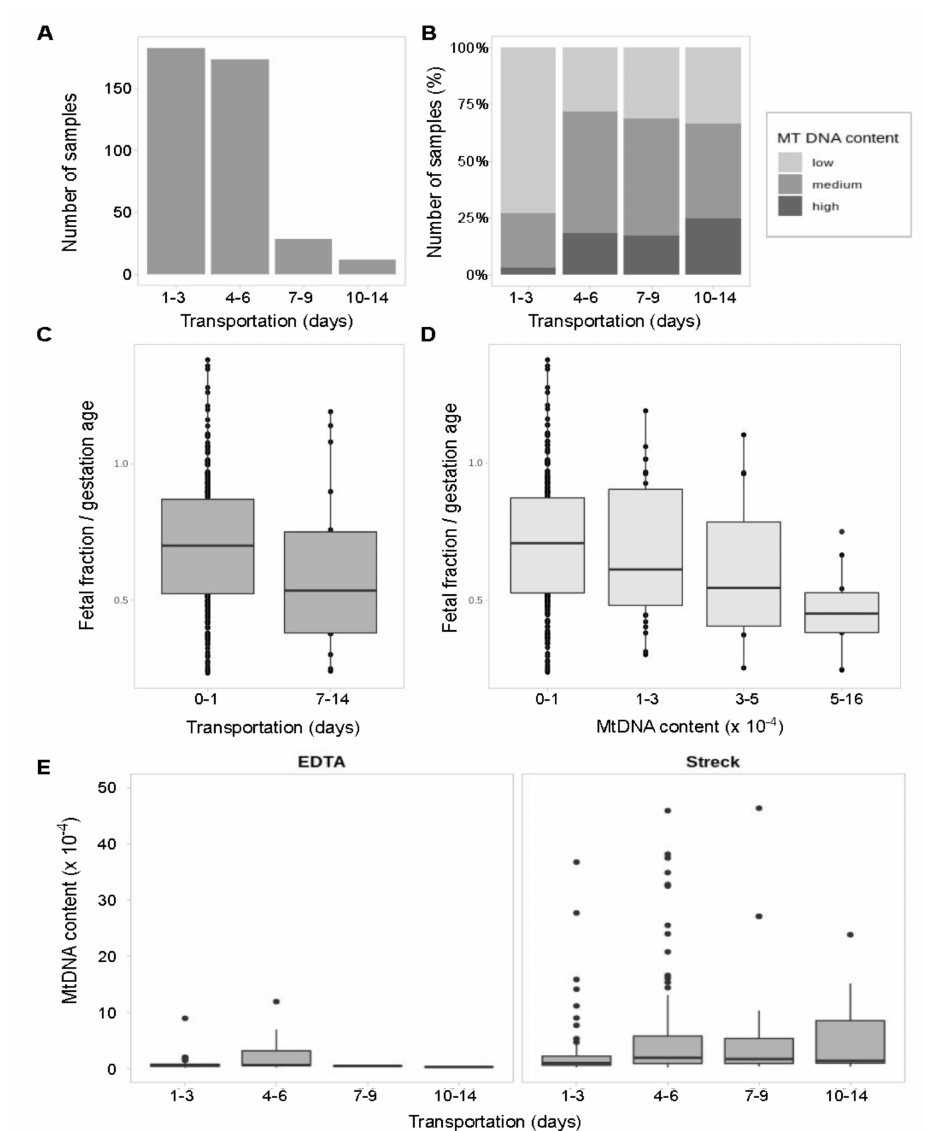
Figure 4. MtDNA content depending on storage conditions and transportation. Statistical significance has been measured with the Kruskal–Wallis test. ( A ) Distribution of samples according to time of transportation (days). ( B ) Distribution of samples with low, medium and high mtDNA content within each time period (percentage). ( C ) Foetal fraction scaled to gestation age in samples shipped under or over 7 days. No statistically significant difference found ( p = 0.09). ( D ) Foetal fraction scaled to gestation age in samples grouped by mtDNA rate. The difference is statistically significant ( p = 0.007). ( E ) Temporal dynamic of mtDNA content in cfDNA fraction extracted from samples stored in EDTA (blood plasma) or Streck (whole blood) sample tubes. The difference is significant for Streck samples ( p =